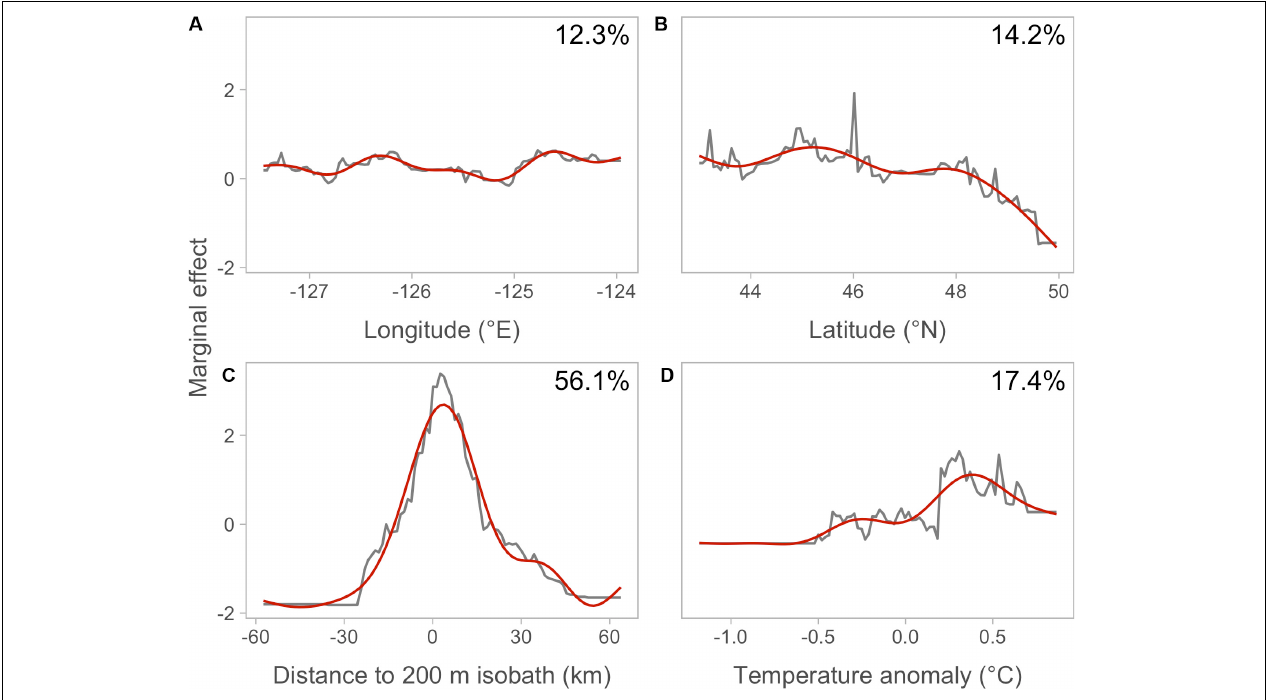
FIGURE 3 | Marginal effects of covariate smooths from the BRT. Each panel shows a single covariate: (A) longitude, (B) latitude, (C) distance to 200 m isobath, and (D) temperature anomaly. Gray lines show the marginal effects and red lines show smoothed marginal effects. Percentages give relative influence (i.e., percentage contribution) of each variable in explaining model